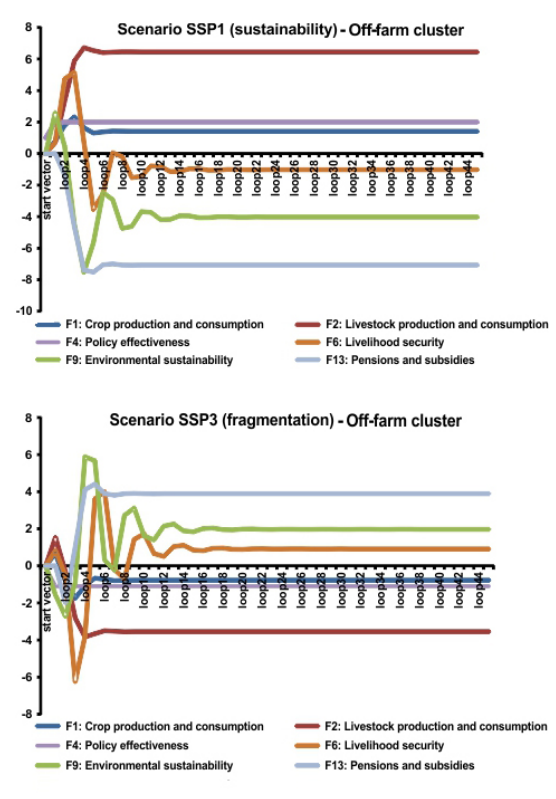
Fig. 8 . Output of the SSP1 scenario (sustainability) and of the SSP3 scenario (fragmentation) for the off-farm cluster. X-axis: number of iterations of vector matrix, indicating the number of loops necessary to the stabilization; Y-axis: value of the factors. Values indicate the importance of the factor in different